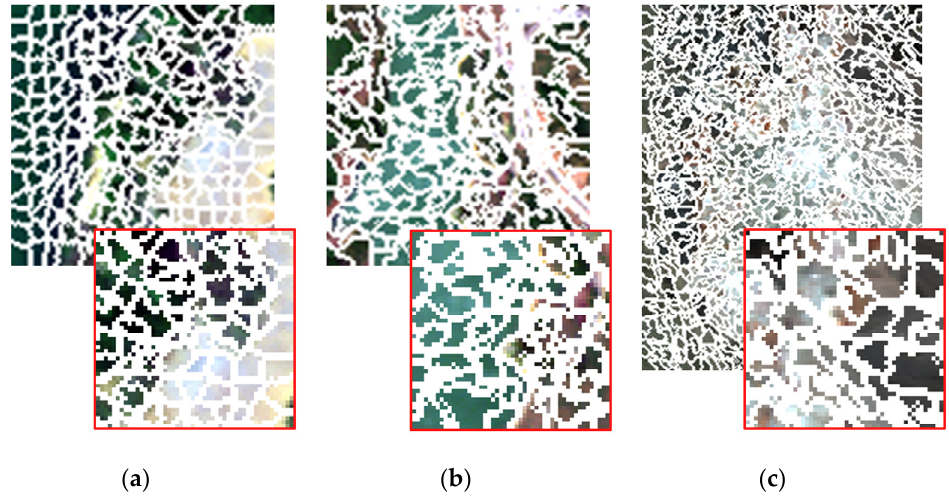
Figure 7. The results of spatial clustering. ( a ) Samson; ( b ) Jasper Ridge; ( c ) Cuprite. Pt represents the percentage of pixels reserved from each partition for representative endmember generation. To analyze the impact of Pt, an experiment is conducted. After completing the spatial clustering with s and λ 1 being 6 and 0.1, respectively, choose pixels in each partition with Pt from 0.05 to 0.95 at an interval of 0.01, and the indexes are calculated each time. The results are shown in Figure 8.